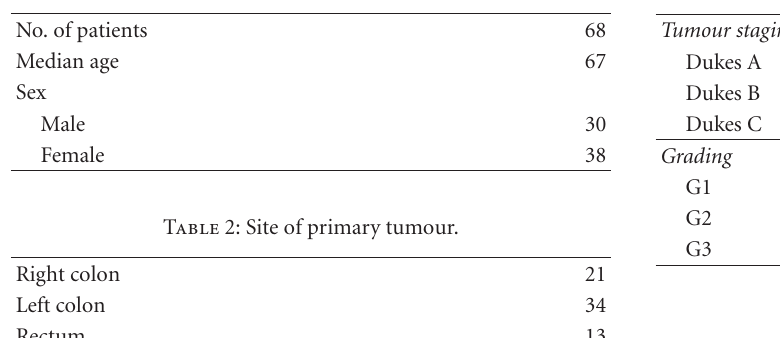
Table 3: Tumour staging and grading.